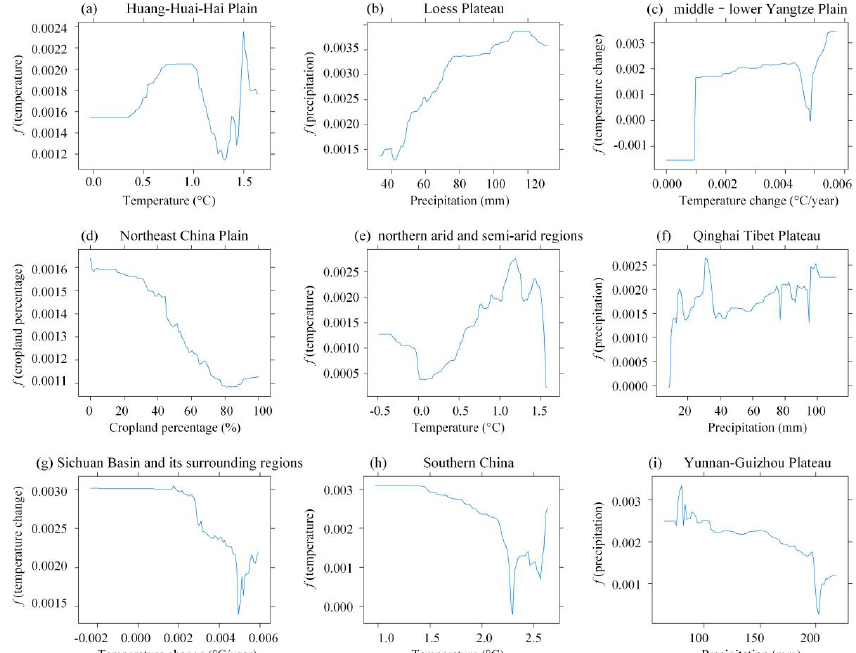
Figure 11. Partial dependence plots showing the relationships between GLASS NDVI trends from to 2015 and their most important cropland and climate predictors in the ( a ) Huang-Huai-Hai Plain, 1982 to 2015 and their most important cropland and climate predictors in the (a) Huang-Huai-Hai Plain, (b) Loess Plateau, (c) middle–lower Yangtze Plain, (d) Northeast China Plain, (e) northern arid ( b ) Loess Plateau, ( c ) middle–lower Yangtze Plain, ( d ) Northeast China Plain, ( e ) northern arid and and semi-arid regions, (f) Qinghai Tibet Plateau, (g) Sichuan Basin and its surrounding regions, (h) semi-arid regions, ( f ) Qinghai Tibet Plateau, ( g ) Sichuan Basin and its surrounding regions, ( h ) Southern Southern China, and (i) Yunnan-Guizhou Plateau agricultural zones. China, and ( i ) Yunnan-Guizhou Plateau agricultural